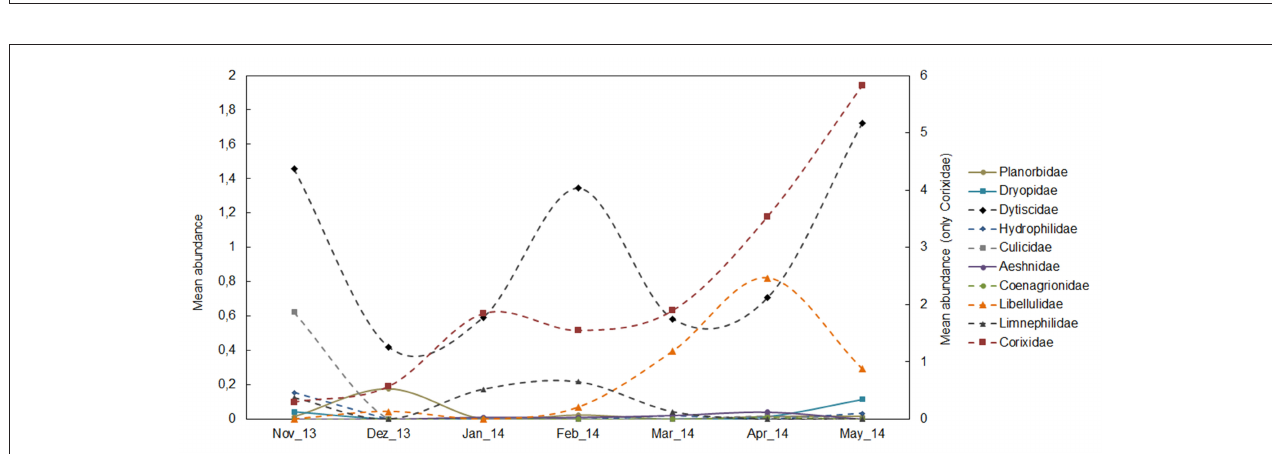
FIGURE 3 | Average number of individuals at the Family taxonomic level calculated per pond and month during the monthly sampling. Because of their high abundance, the Fam. Corixidae is indicated in an additional axis (see ESM4 in the Supplementary Material for details).